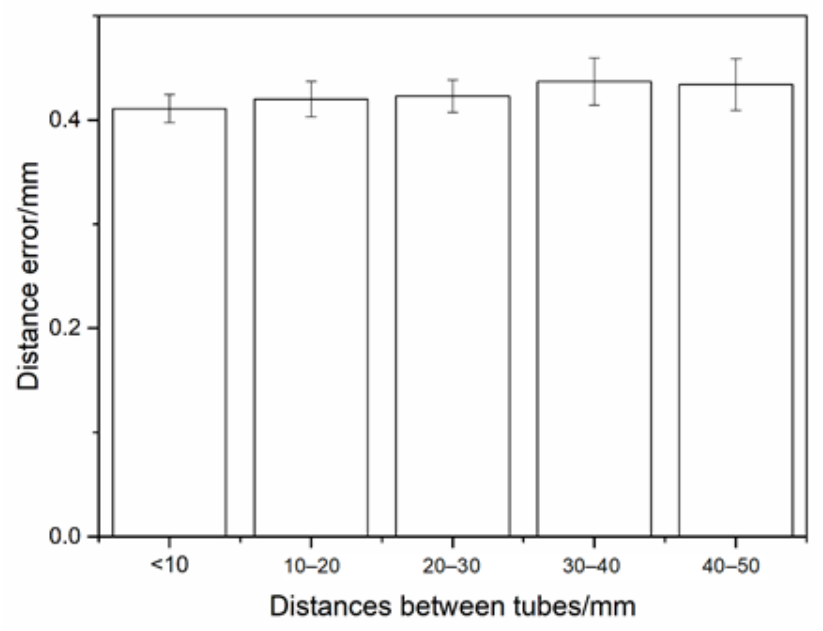
Figure 18. Distance error of the complex tube system